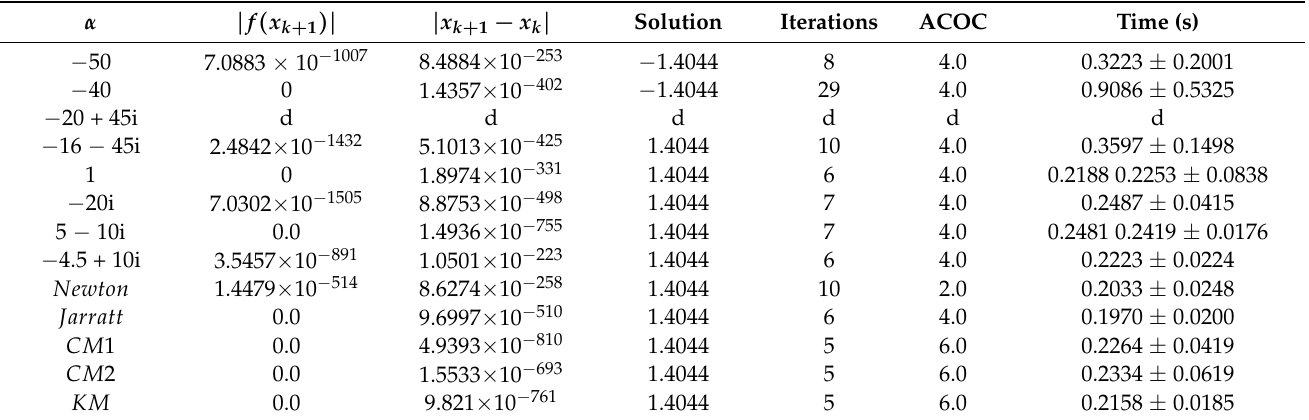
Table 1. f 1 ( x ) = sin 2 x − x 2 + 1, x 0 =